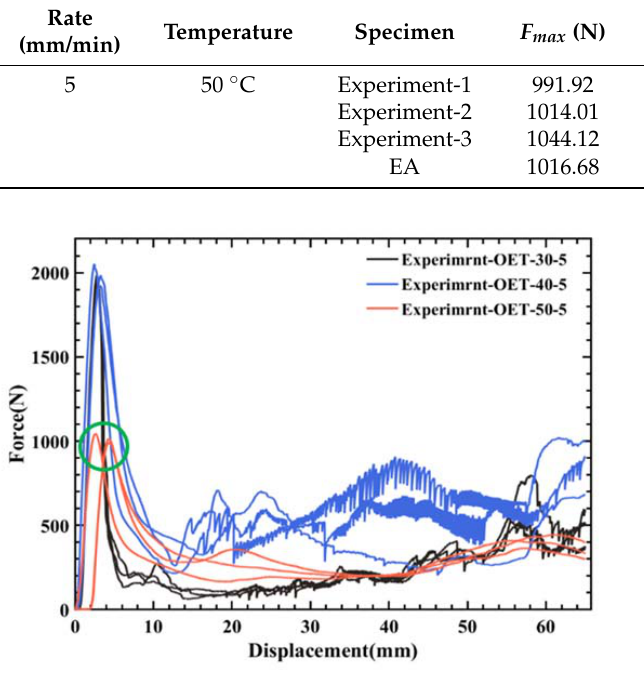
Figure 9. The compression rate at 5 mm/min: force–displacement curves of OET axial compression experiment at 30 °C, 40 °C, and 50 °C.